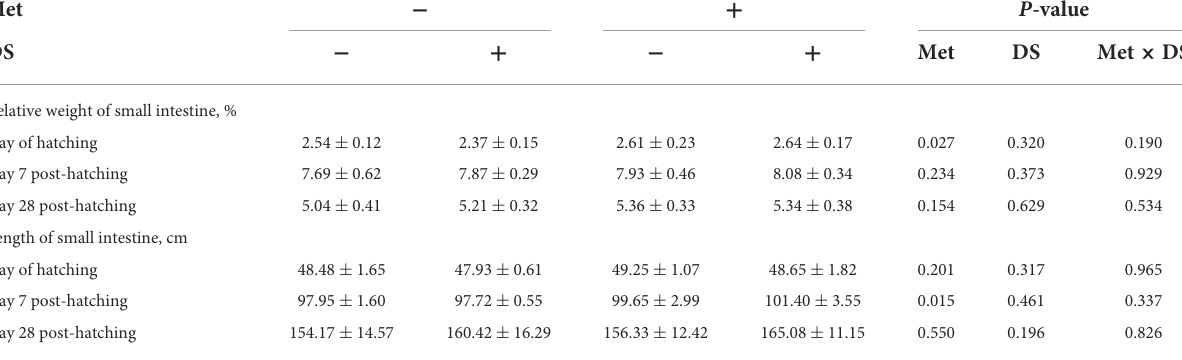
TABLE 8 Effects of in ovo injection of methionine (Met) and disaccharide (DS) on small intestine parameters of geese during the early-life post-hatching a,b .